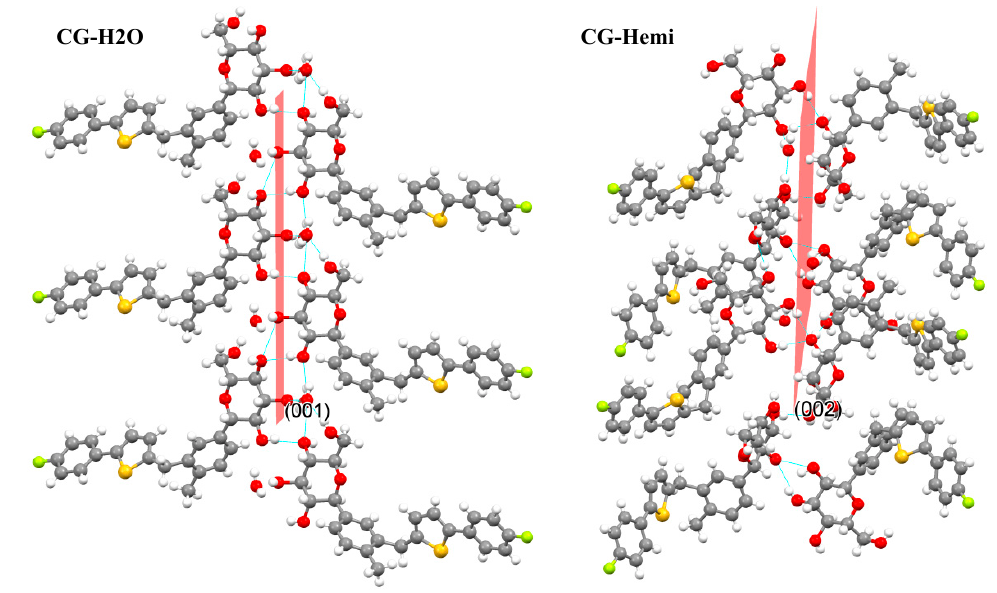
Figure 9. Crystal packing of CG-H 2 O along (001) face and crystal packing of CG-Hemi along (002) face.